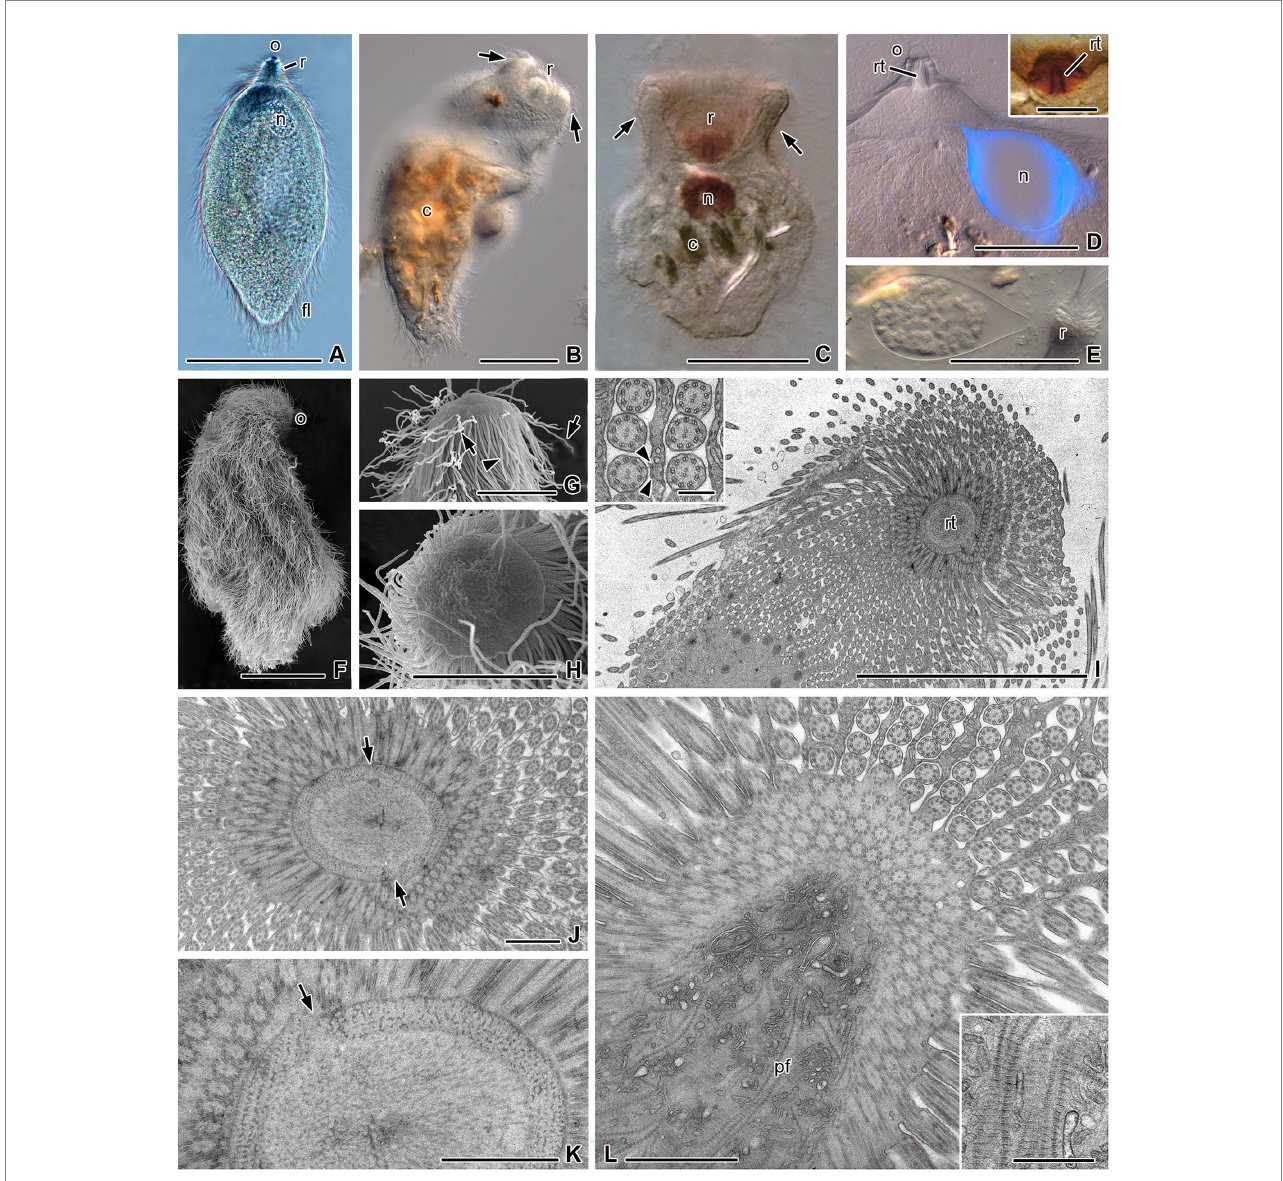
FIGURE 1 Morphology of Retractinympha glossotermitis and ultrastructural details of its anterior cell pole. (A) Lemon-shaped living cell with a cap-like operculum (o) at the tip of the rostrum (r), a granular nucleus (n), and complete cover with flagella (fl). (B,C) Cells with rostrum retracted in a bowl-like indentation and lignocellulose particles (c). (D) Anterior half of a cell with DAPI-stained, pear-shaped nucleus, hemispherical operculum, and rostral tube (rt). Inset: rostrum with rostral tube. (E) Pear-shaped nucleus with condensed chromosomes and anterior hyaline region. (F) A cell completely covered with flagella, except at the operculum. (G) Dome-shaped operculum, lateral view; helical spirochetes (arrows) are attached between the short flagella (arrowhead). (H) Circular operculum, top view. (I) Oblique section through anterior cell pole with rostral tube and longitudinal rows of flagella flanked by thin cytoplasmic ridges. Inset: Flagella attached to ridges by electron-dense cell contacts (arrowheads). (J,K) Cross-sections through anterior part of rostrum; rostral tube bordered by a dense layer of parabasal filaments and loosely arranged filaments inside tube; arrows indicate disjuncture of rostral tube wall. (L) Oblique section through posterior part of rostrum; interior filled with cross-striated parabasal filaments and vesicles. Inset: Parabasal filaments in higher magnification. (A–E) Light microscopy. (A) Bright field, (B–E) differential interference contrast, (D) DAPI staining , and (inset D ) protargol staining. (F–H) Scanning